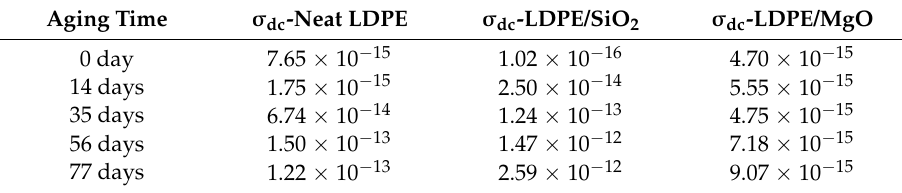
Table 1. DC conductivity of materials from fitting data. LDPE: low-density polyethylene. Aging